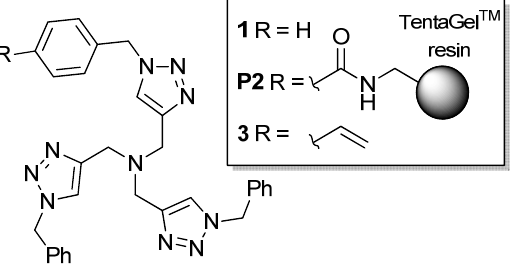
Figure 1. Tris[(1-benzyl-1 H -1,2,3-triazol-4-yl)methyl]amine (TBTA) ligand ( 1 ), commercial supported variant ( P2 ), and TBTA styryl monomer ( 3 ).